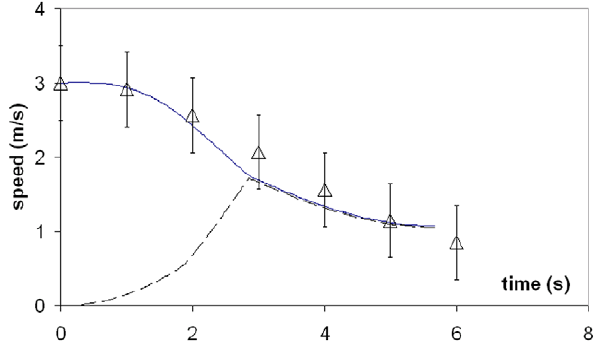
Figure 5. Simulated forces acting on a 20.2 m fin whale. Temporal variations of total drag ( F SD + F ED ; continuous line), engulfment drag ( F ED ; dash-dotted), shape drag ( F SD ; dotted) and combination of fluking thrust and weight-adjusted buoyancy ( F thrust + F ext ; dash-doubly-dotted). Mouth closure begins at the 2.85 s mark and is characterized by shape drag cancelling F thrust + F ext per equation 24.